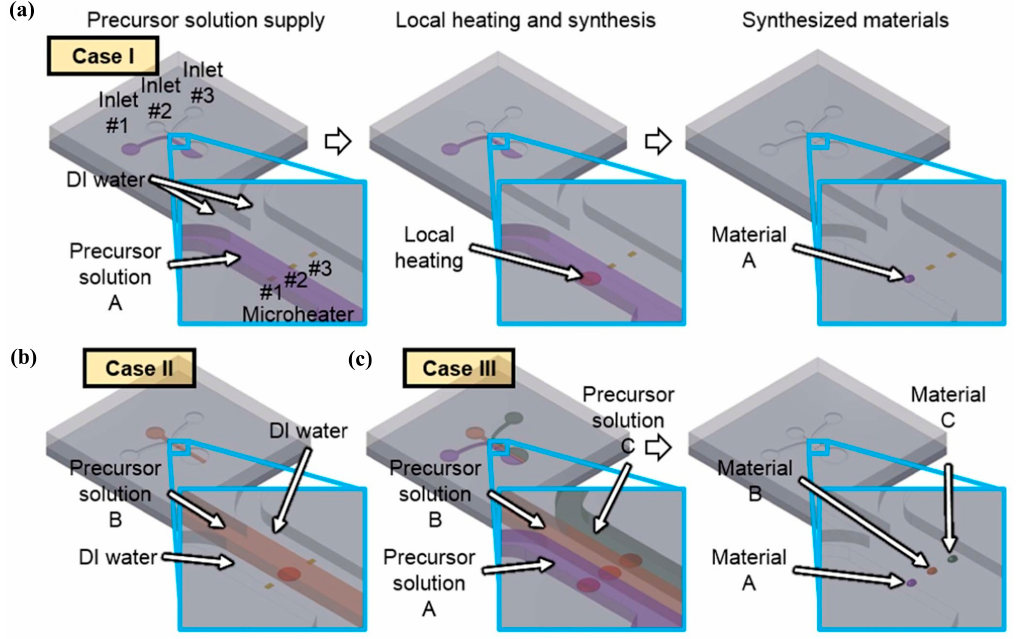
Figure 5. Local synthesis of nanomaterials in microfluidic channel. ( a ) selective and localized synthesis of material A on microheater 1. ( b ) Synthesis of nanomaterial B on microheater 2. ( c ) Parallel synthesis of heterogeneous nanomaterial array. Reproduced with permission under the terms of the CC-BY-NC-ND 4.0 license from [48] Copyright 2015, The Authors, published by Nature.